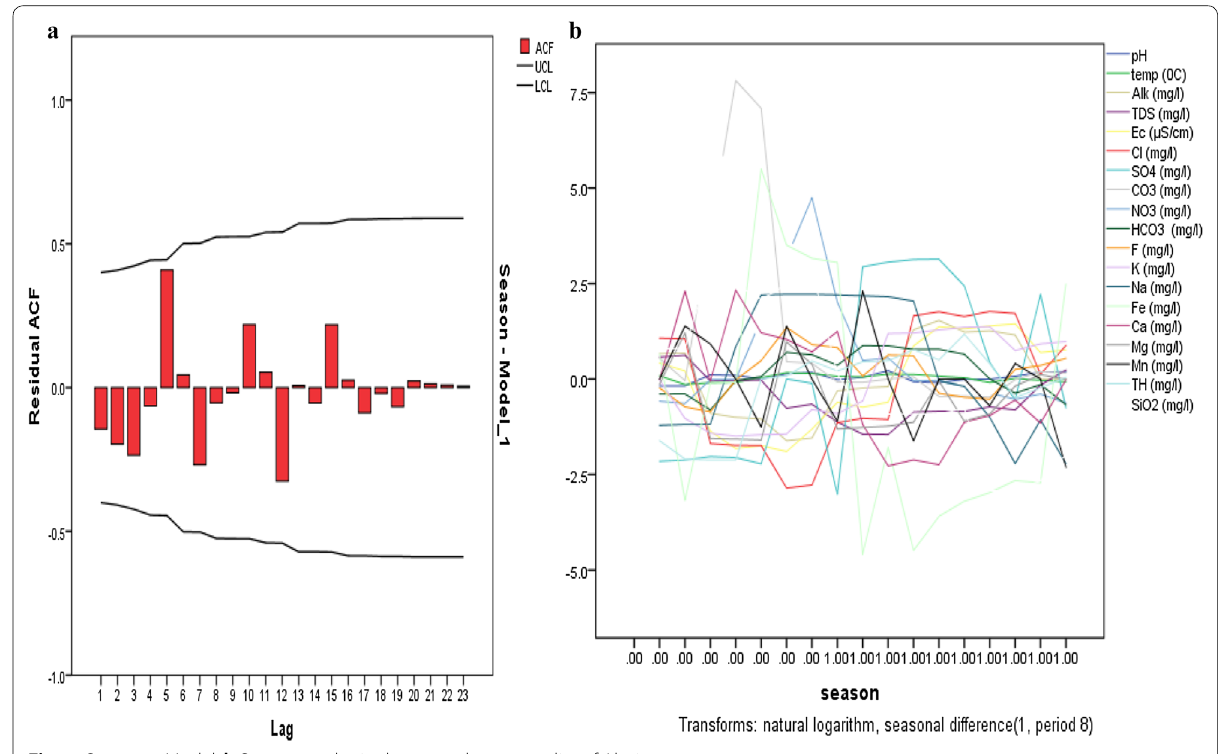
Fig. 5 Season: a Model. b Sequence plot in the ground water quality of Abuja